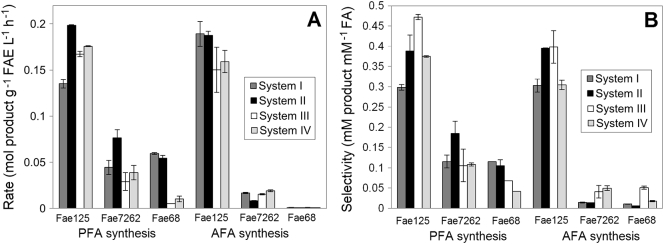
Effect of medium composition on the a) rate and b) selectivity. Reactions were carried out in n-hexane: t-butanol: 100 mM MOPS-NaOH pH 6.0, 50 mM VFA, 200 mM prenol or 30 mM L-arabinose, 40 °C, 8 h. Dark gray: system I (37.8: 57.2: 5.0 v/v/v), black: system II (53.4: 43.4:3.2 v/v/v), white: system III (47.2: 50.8: 2.0 v/v/v), light gray: system IV (19.8: 74.7: 5.5 v/v/v).